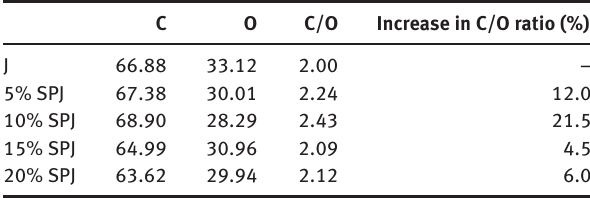
Table 1: Surface chemical compositions (%) of the jute